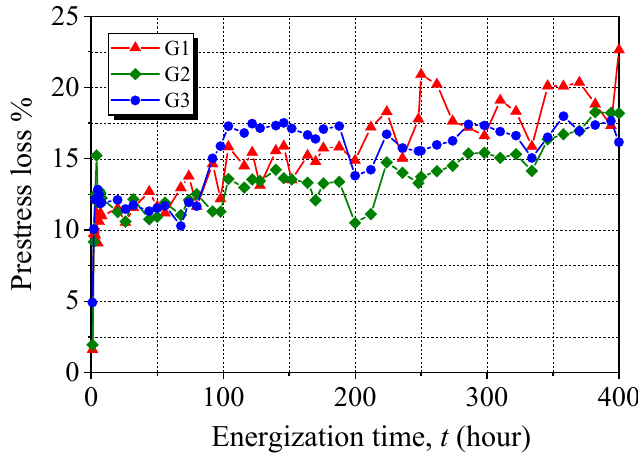
Figure 12. Prestress loss of the CFRP laminate with a wedge anchor during 400-h accelerated corro- sion.